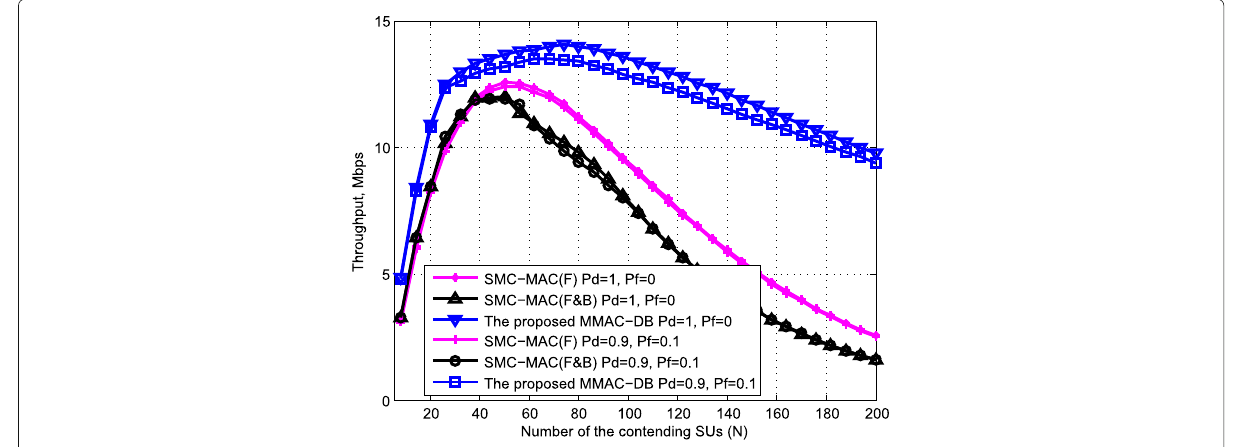
Fig. 14 Throughput comparison with M = 30, α = 0.1. Throughput comparison for scene